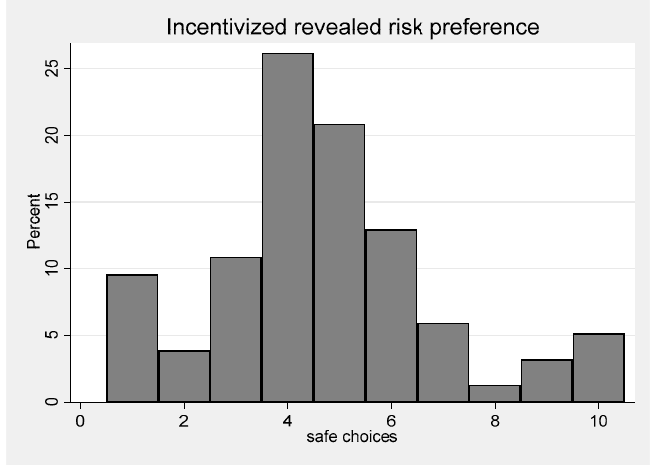
Figure 2. The incentivized revealed risk preference (IRRP) graph shows percentage of respondents by the number of safe choices. Subjects who made a single safe choice are highly risk loving ‘bar graph 1 ’ while those that made 10 safe choices ‘ bar graph 10 ’ are highly risk averse.